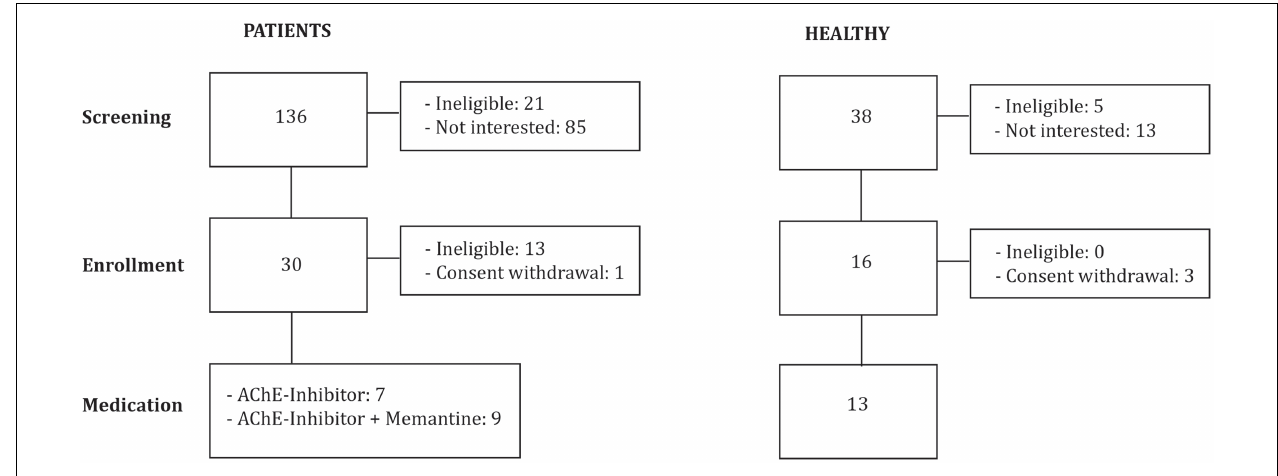
FIGURE 1 | Flow diagram of the enrollment process and final study participants analyzed